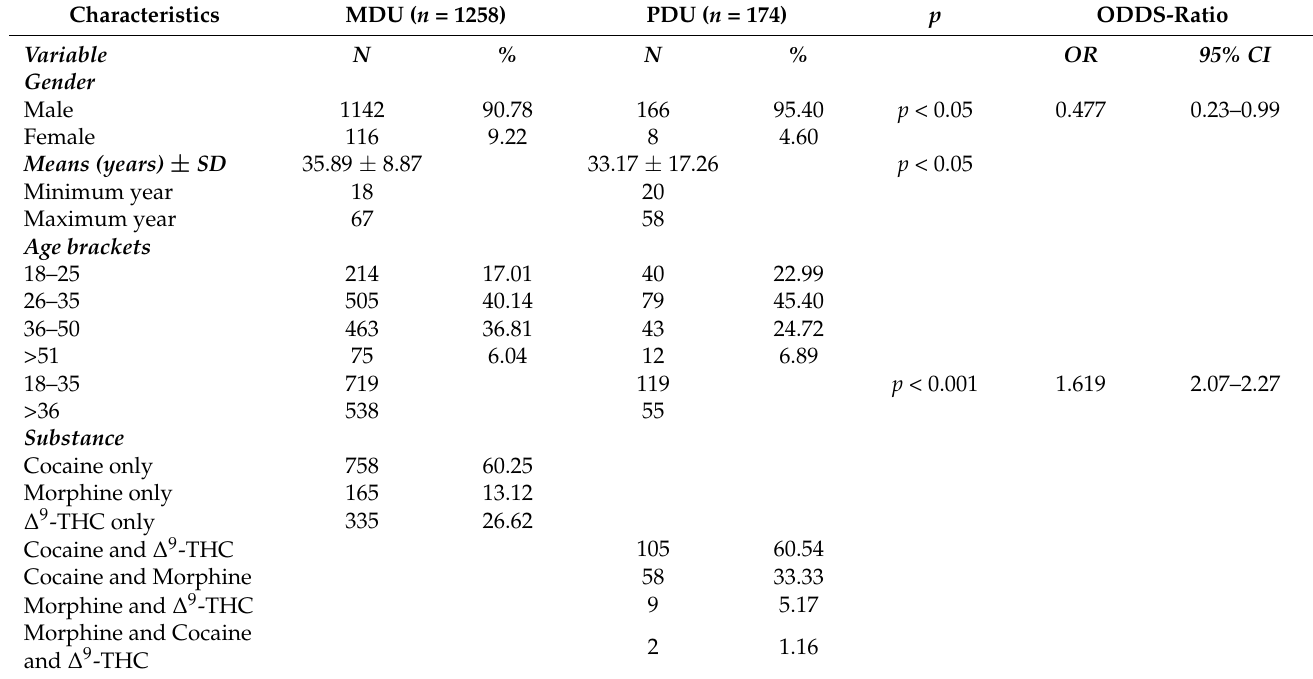
Table 1. Characteristics of monodrug users’ group (MDU) and polydrug users’ group (PDU).